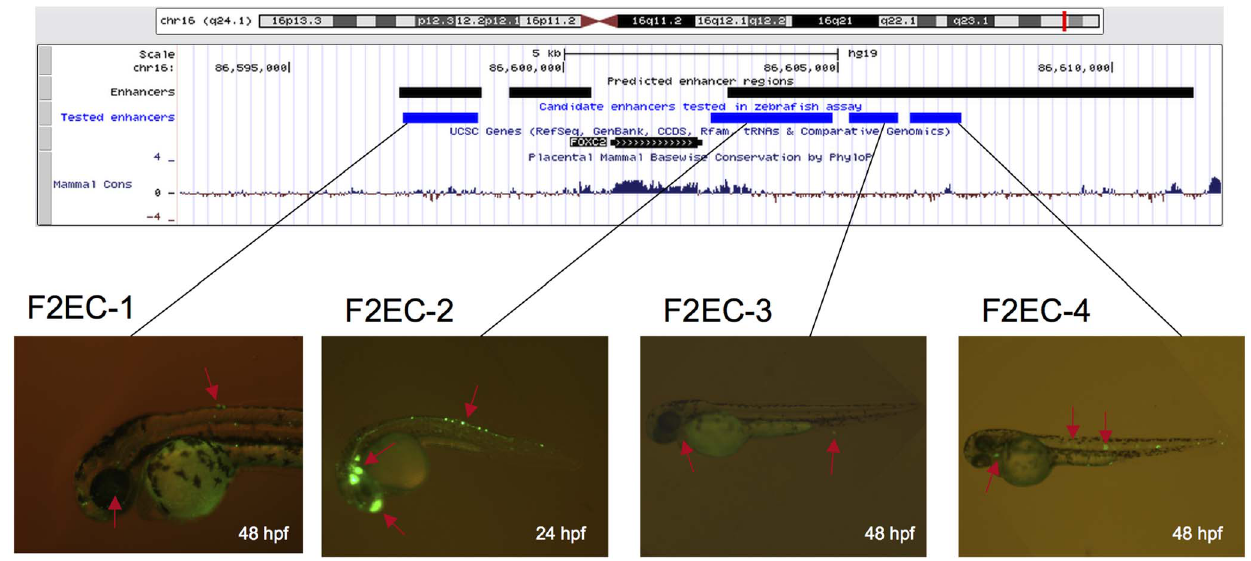
Figure 7. Four novel developmental enhancers near FOXC2 . This UCSC Genome Browser (http://genome.ucsc.edu) snapshot shows the genomic context of four candidate human enhancers tested in transgenic zebrafish. For each enhancer, we show a zebrafish image that is representative of the reproducible expression patterns. FOXC2 Enhancer Candidate 1 (F2EC-1) drives expression at 48 hpf in the eye and epidermis (arrows). F2EC-2 shows expression at 24 hpf in the forebrain, midbrain, and nerve. F2EC-3 drives expression at 48 hpf in the epidermis and heart. F2EC-4 shows expression at 48 hpf in the notochord, spinal cord, and heart. See Table S6 for full list of expressed tissues seen in each candidate enhancer and Figure S10 for results on candidate enhancers near FOXC1